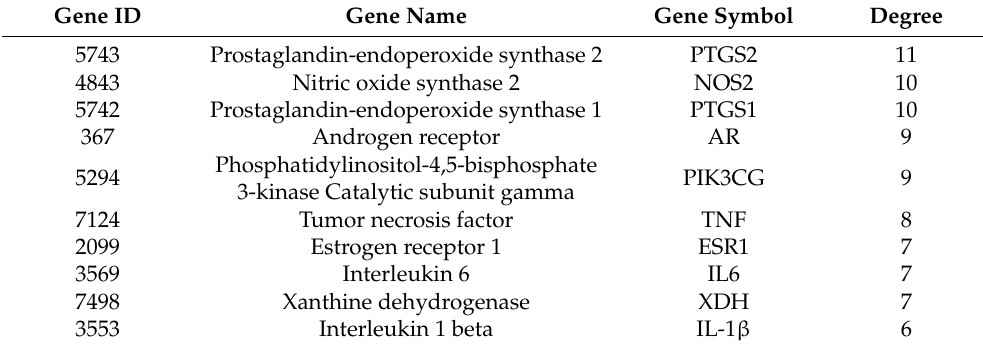
Table 3. The top 10 hub genes with higher degree of connectivity.